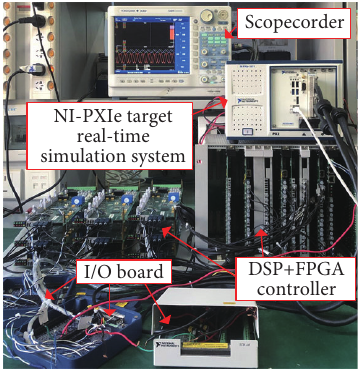
Fig. 12 Hardware-in-the-loop experimental